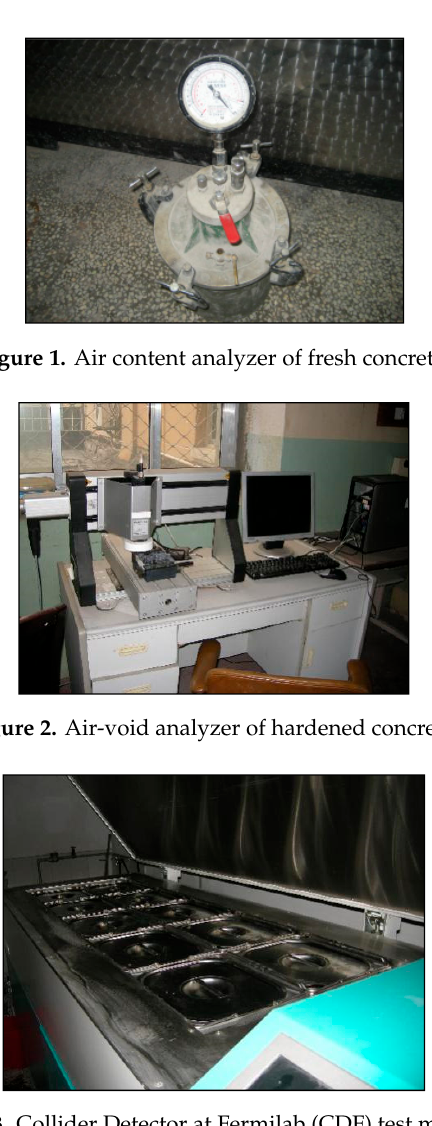
Figure 1. Air content analyzer of fresh concrete.